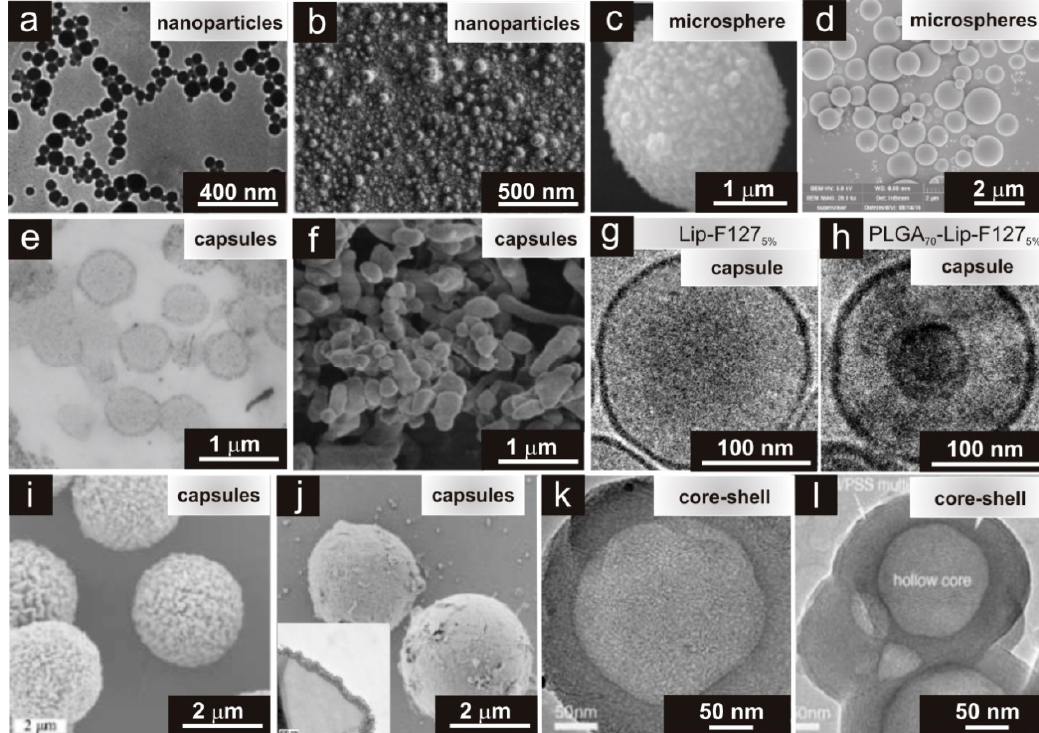
Figure 4. Morphology (structure) of HGs observed by ( a , c , e , g , h ) TEM and ( b , d , f,i,j ) SEM at different magnifications (the scale bars are marked on the images) obtained by post-loading or in situ loading drugs. ( a , b ) Piperlongumine-loaded poly(ethylene glycol)-poly(dehydroabietic ethyl methacrylate) HG nanoparticles [172]. ( c ) Silver alginate HG microspheres [173]. ( d ) Thermosensitive HG microspheres loaded with tenofovir [174]. ( e , f ) Polyacrylamide-poly( N -isopropylacrylamide) HG capsules loaded with doxorubicin hydrochloride [175]. ( g ) Unloaded lipid capsule (Lip) with F127 5% (5 wt% content of Pluronic F127) [176]. ( h ) Doxorubicin-loaded poly(lactic-co-glycolic acid) (PLGA) core-lipid shell (Lip) with F127 5% structure [176]. Smart organic/inorganic HG polyelectrolyte capsules (poly(allylamine hydrochloride): ( i ) hollow and ( j ) hydroxyapatite [177]. ( k , l ) Core-shell mesoporous silica spheres ( l ) loaded with ibuprofen [178]. Reprinted with permission from Refs. [172–178]. The Royal Society of Chemistry, Hindawi, Nature Group, Springer and Wiley-VCH Verlag GmbH & Co.